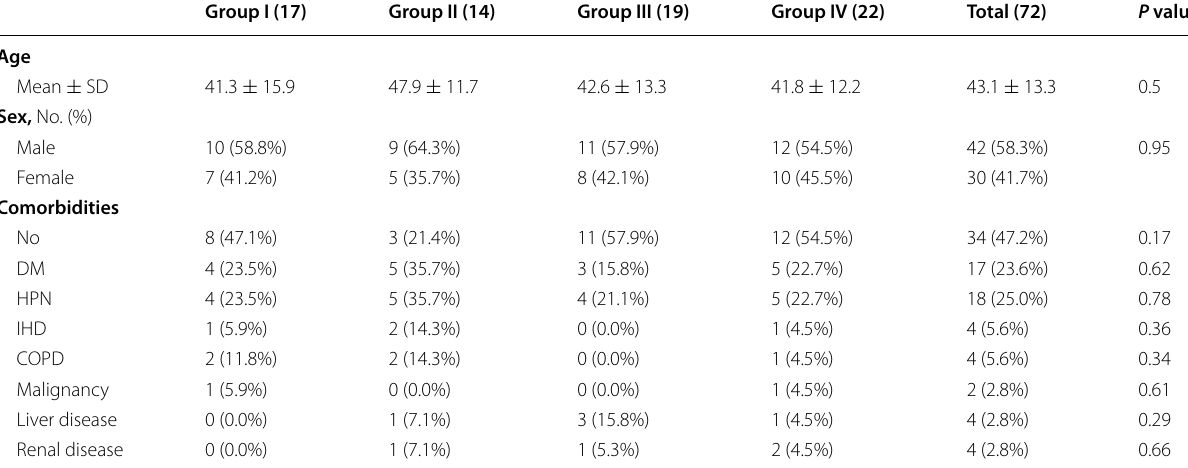
Table 1 The demographic characteristics of patients with different sonographic groups